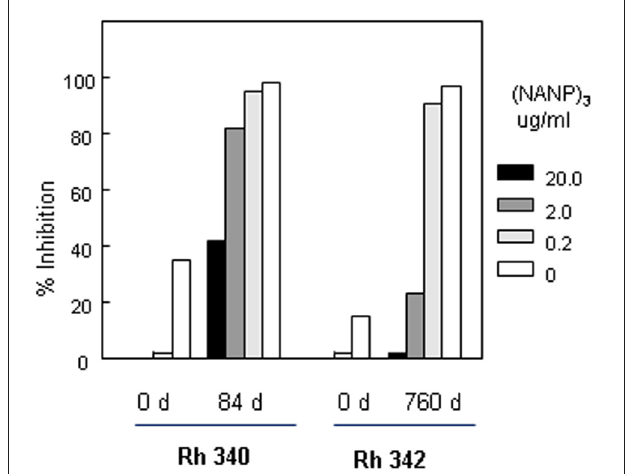
FIGURE 8 | Peptide competition TSNA. Rhesus macaque #340 (Rh 340) serum from Days 0 and 84 was tested at 1:10 dilution. Serum from Rhesus macaque #342 (Rh 342) obtained on Days 0 and 760 was tested at 1:20 dilution. Serum was pre-incubated with 10-fold dilutions of (NANP) 3 competitor peptide prior to addition of PfPb sporozoites and completion of TSNA. Day 0 serum was tested with and without 20 µ g/ml of (NANP) 3 peptide